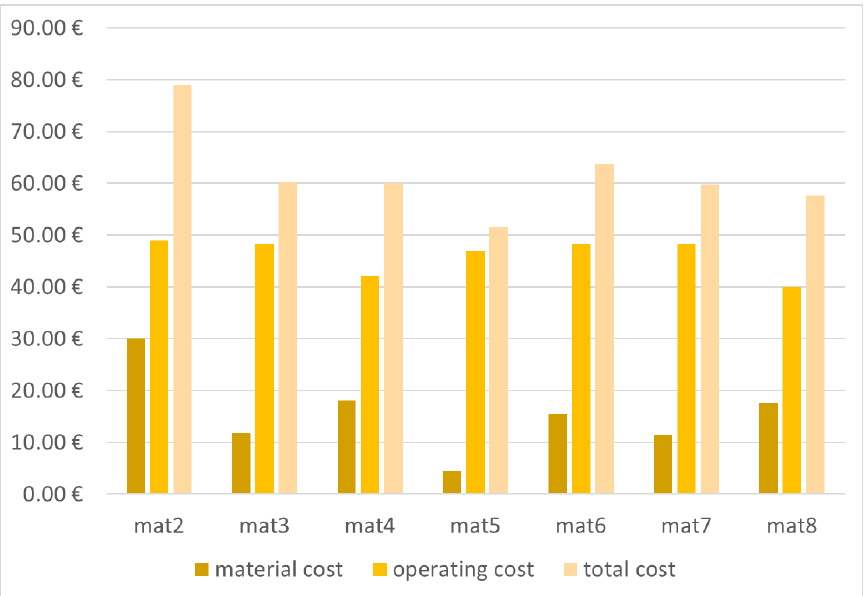
Figure 9. Graphical representation of costs for the heat-reflective materials reported in Table 7.